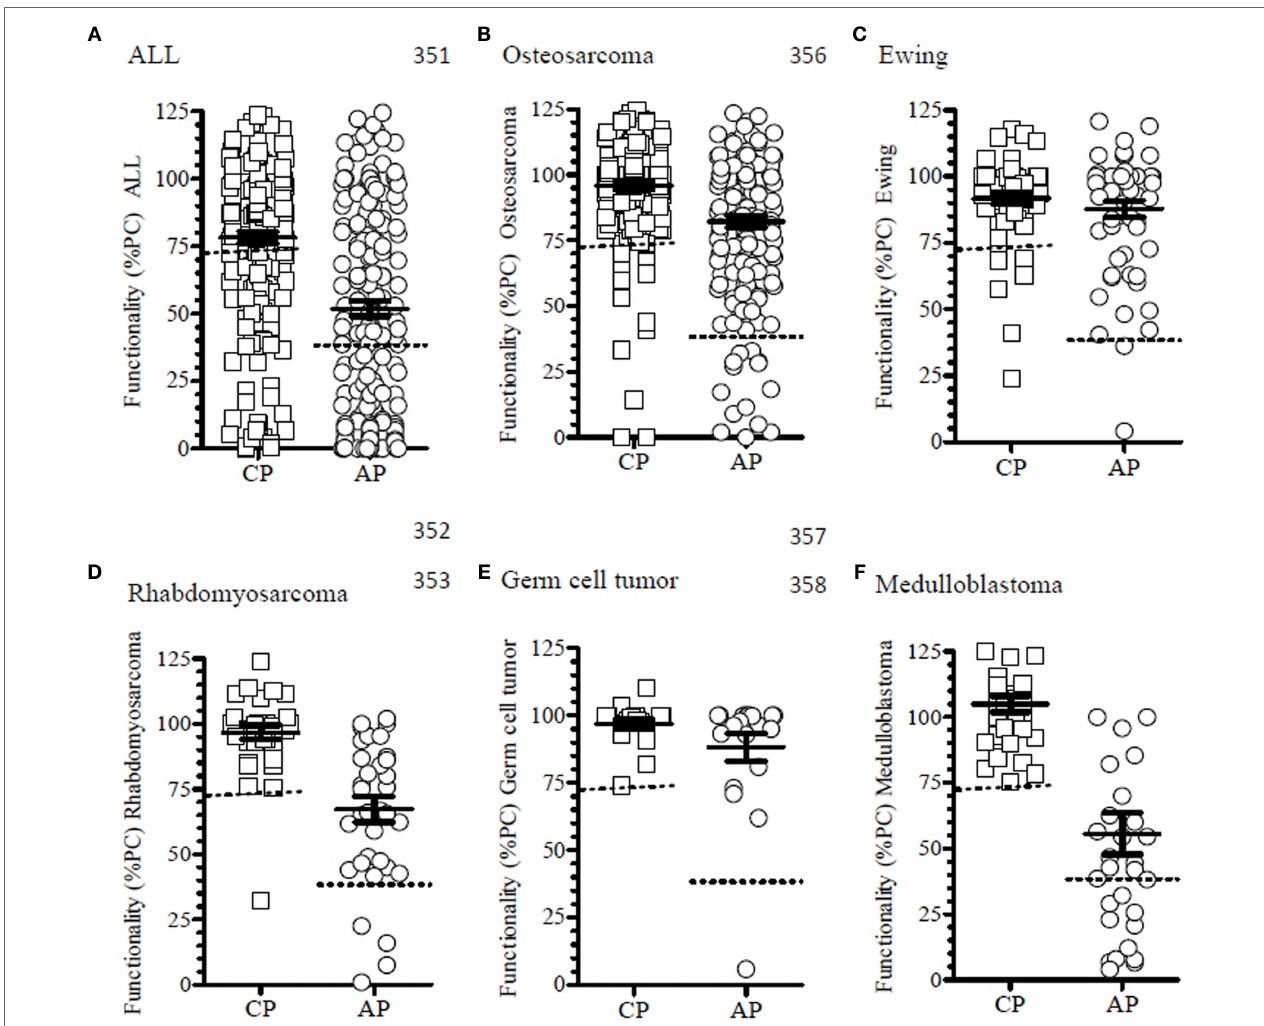
FigUre 4 | The functionality of the complement system of patients within the different treatment protocols . (a) In patients with ALL, 47.6% ( n = 79/200) of the time points showed a reduced functionality of the complement system. There were 63.3% ( n = 50/79) and 91.1% ( n = 72/79), which were related to the CP or AP, respectively. (B) In patients with osteosarcoma and treated according to the EURAMOS I protocol, 23 time points (12.2%) had a reduction in complement functionality. Of these, 23 moments 60.9% ( n = 14/23) and 78.3% ( n = 18/23) where in CP and AP, respectively. (c) Ewing sarcoma patients had in 14.5% ( n = 9/62) a reduced functionality, but they were mostly related to the CP (88.9%, n = 8/9) and to a lesser extent to the AP (22.2%, n = 2/9). (D) Patients with rhabdomyosarcoma treated according to EpSSG protocol showed in 11.4% of the analyzed samples complement defects ( n = 4), which were all related to the AP (100%). (e) Patients with germ cell tumors had no reduced functionality apart from a single time point in AP activity (5%, n = 1). (F) Patients with medulloblastoma had only defects in 41.9% of the samples ( n = 13/31) and all were in the AP. Mean ± SEM are shown. Functionality is depicted as percentage of a positive control